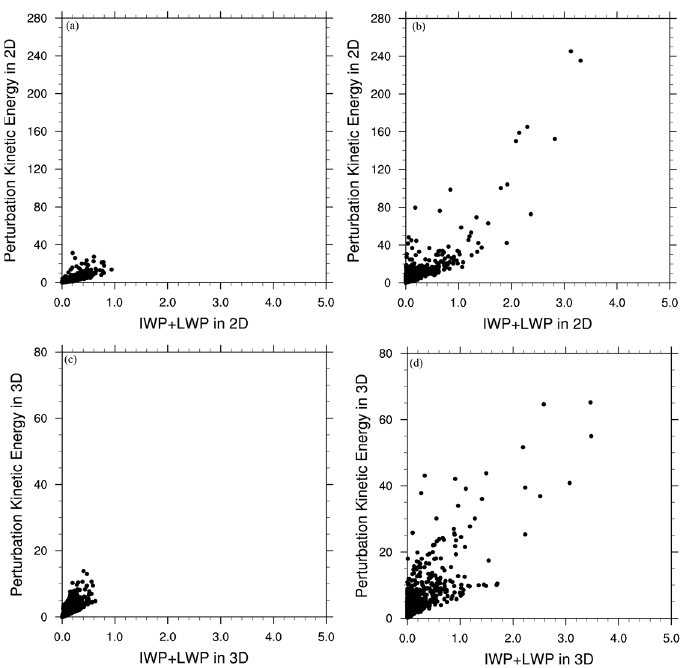
Figure 5. Scatterplots of vertical sum of IWP+LWP versus PKE (unit: 10 3 J m − 2 ) for ( a ) convective component from 2D CRM simulation, ( b ) stratiform component from 2D CRM simulation, ( c ) convective component from 3D CRM simulation, and ( d ) stratiform component from 3D CRM simulation.